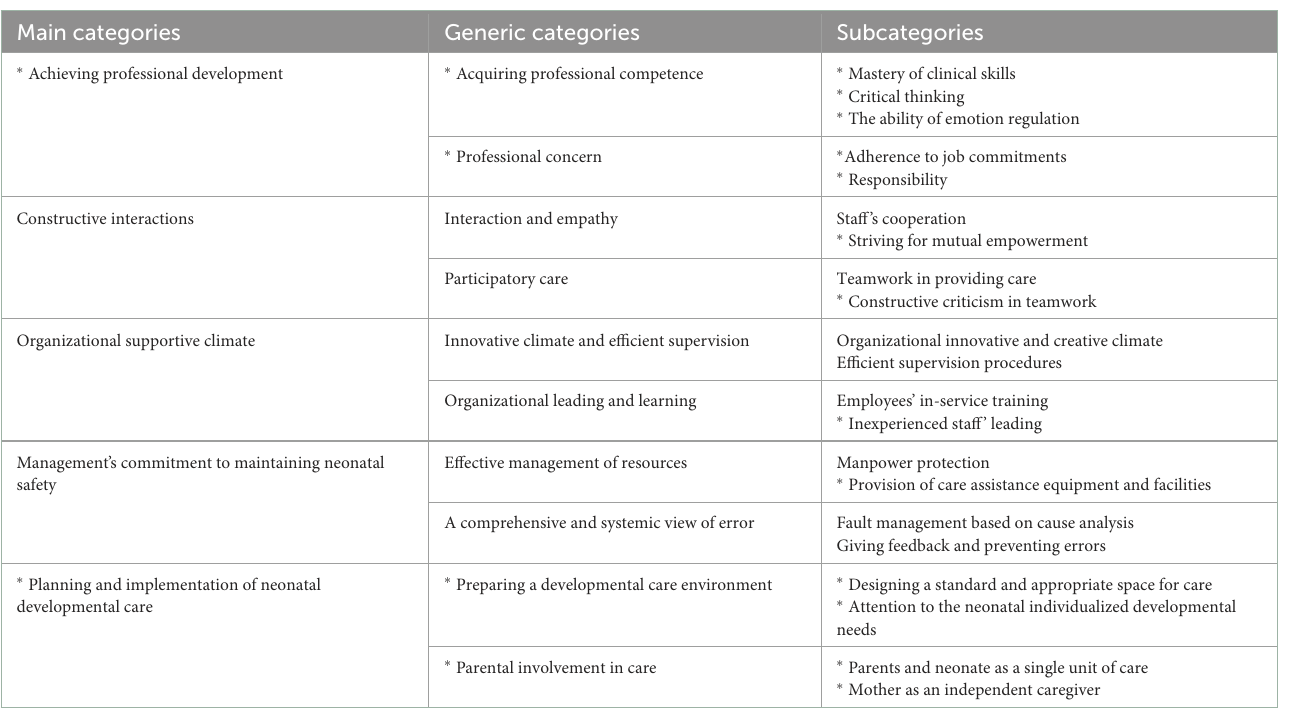
TABLE 3 Main categories, generic categories, and subcategories of safety culture in